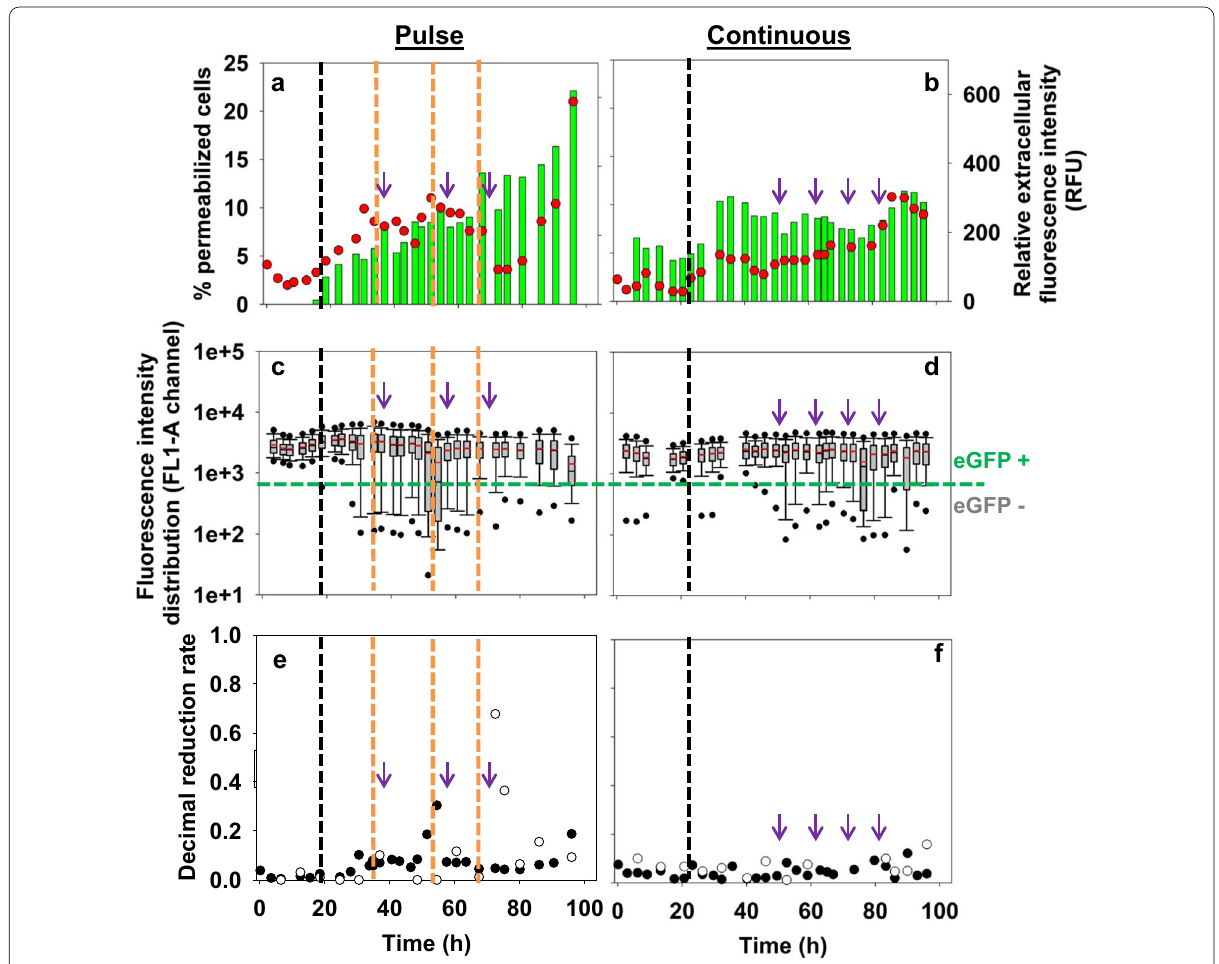
Fig. 3 Relative extracellular fluorescence intensity (FU/OD intact ) ( ) and percentage of permeabilized cells ( ) in the FL3-A channel for Re2133/ pCB1 with kanamycin: with fructose pulse ( a ) and continuous feeding ( b ). Boxplot comparison on fluorescence intensity distribution in the FL1-A channel for Re2133/pCB1 with kanamycin: with fructose pulse ( c ) and continuous feeding ( d ). Evolution of the decimal reduction rate for Re2133/ pCB1 with kanamycin: with fructose pulses ( e ) and continuous feeding ( f ) based on plate count ( □ ) and flow cytometry ( ● ) measurements. Black vertical lines represent the beginning of the fed-batch phase and orange vertical lines represent fructose pulses. Purple arrows represent additions (kanamycin, 100 mg L − 1 ; elements and phosphorus ·